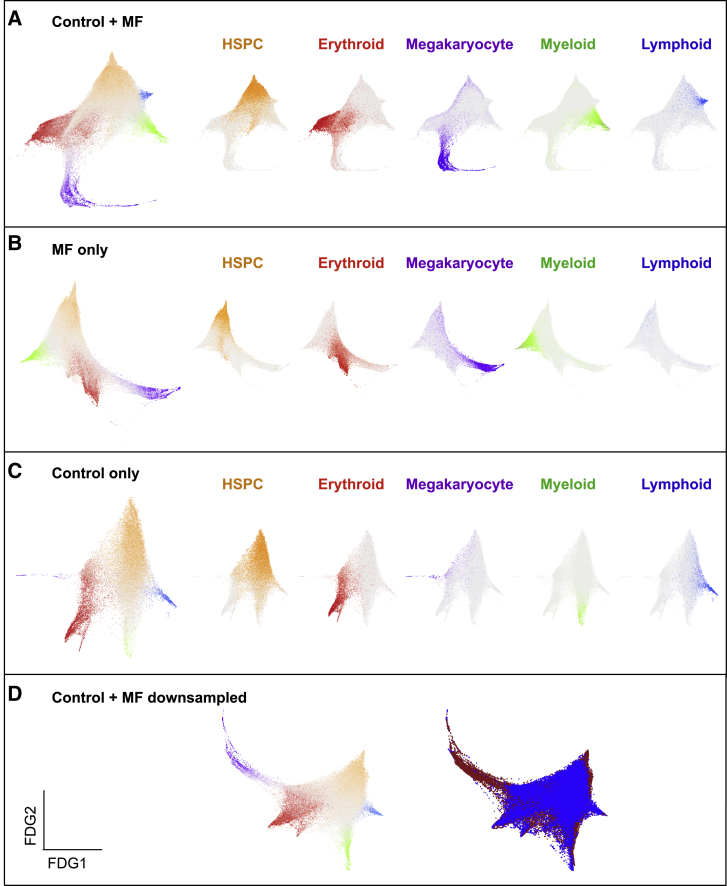
A Distinct Trajectory for Megakaryocyte Differentiation Is Dramatically Expanded in Myelofibrosis(A–D) Force-directed graphs (FDGs) for aggregate of all control + myelofibrosis cells (A), myelofibrosis only (B), control only (C), and control + down-sampled myelofibrosis dataset (D). In (D), the left graph shows lineage signature gene score and in the right graph cells are colored according to the donor type (healthy donors, blue; myelofibrosis, red). Gene expression trajectories are visualized by superimposing the expression scores of lineage signature gene sets on FDG. Grey cells represent uncommitted HSPCs or cells with expression of more than 1 lineage signature. See also Figures S2 and S3 and Table S5.